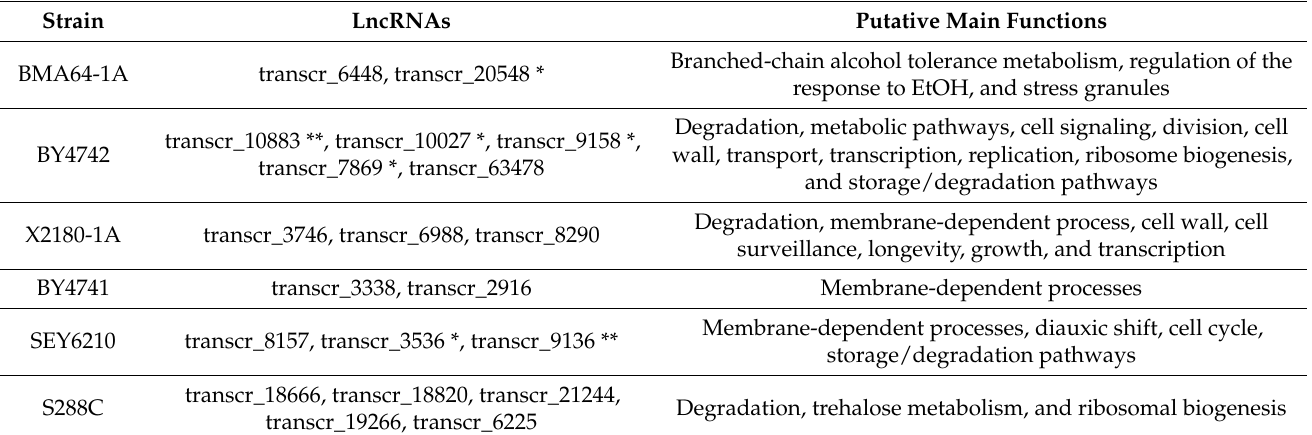
Figure 3. LncRNA propagation analysis of lncRNA‒protein subnetworks associated with EtOH stress-responsive genes. The node colors are related to the biological functions depicted at the bottom of the picture. Only lncRNAs and proteins related to differentially expressed genes were evaluated in this analysis. The conjectures and basis for assigning the functions of lncRNAs presented here are reported in the “Supplementary Text” (“Discussion”, topic “1”). Table 2. General functions of selected EtOH stress-responsive lncRNAs. *, functions assigned by additional analysis or experiments further described. **, lncRNAs that function in the cell cycle [32].